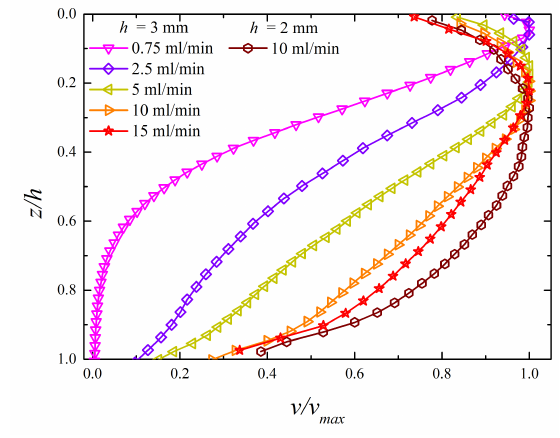
Figure 5. Evolution of velocity profiles normalised with v max and h as the flow rate is increased beyond the Gaussian regime and grain flow occurs in the whole